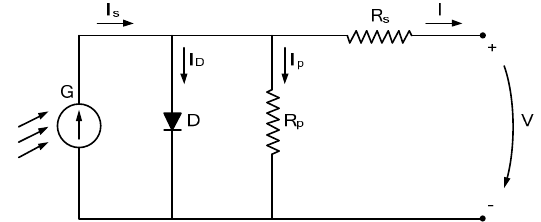
Figure 1. Five-parameter equivalent electric circuit of the photovoltaic (PV)